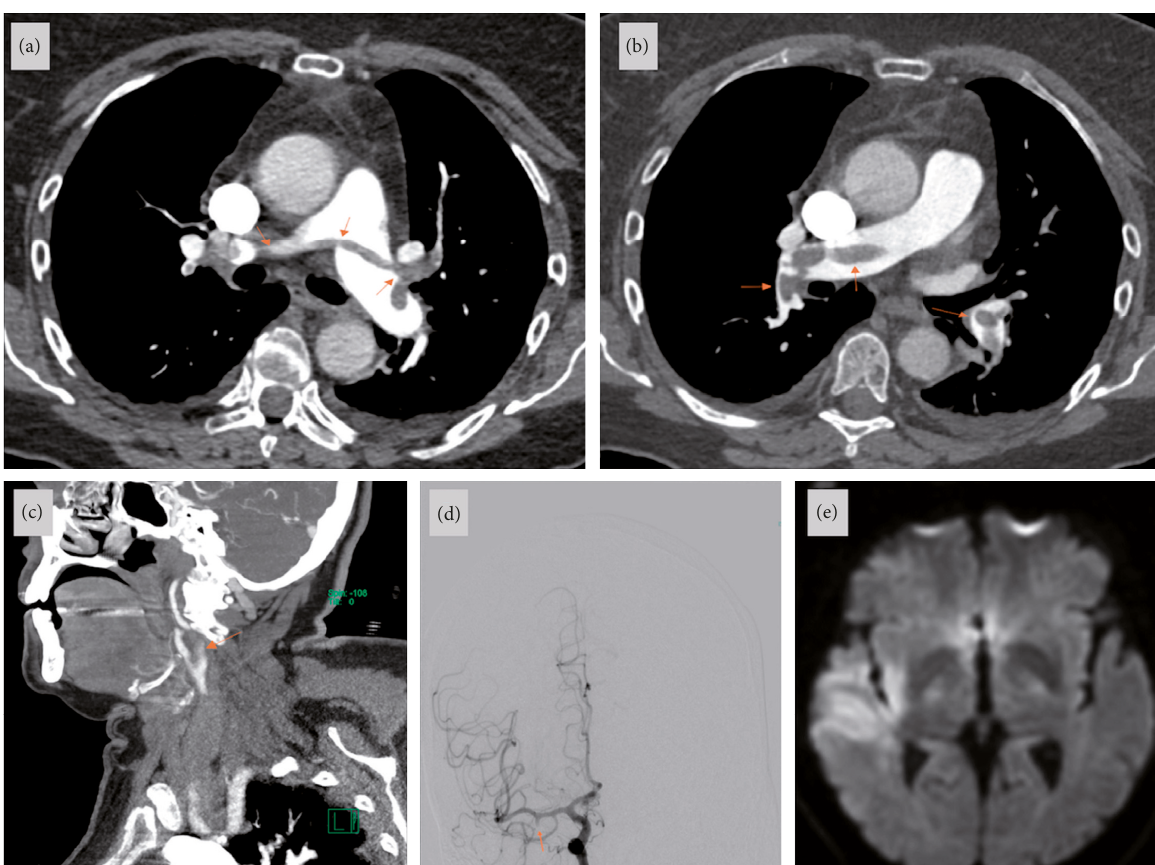
Figure 1: (a, b) Computerized tomography angiography of the chest (axial images) showing “saddle” shaped thrombus in the pulmonary artery bifurcation extending into both trunks (arrows); (c) computerized tomography angiography of the neck (sagittal view) showing right common carotid artery bifurcation showing “saddle-shaped” thrombus in the external and internal carotid arteries (arrow); (d) digital subtraction angiography with selective right internal carotid artery injection showing middle cerebral artery inferior division occlusion (arrow); (e) magnetic resonance imaging of the brain diffusion-weighted imaging axial section showing right frontotemporal area infarction corresponding to the middle cerebral artery inferior branch occlusion.